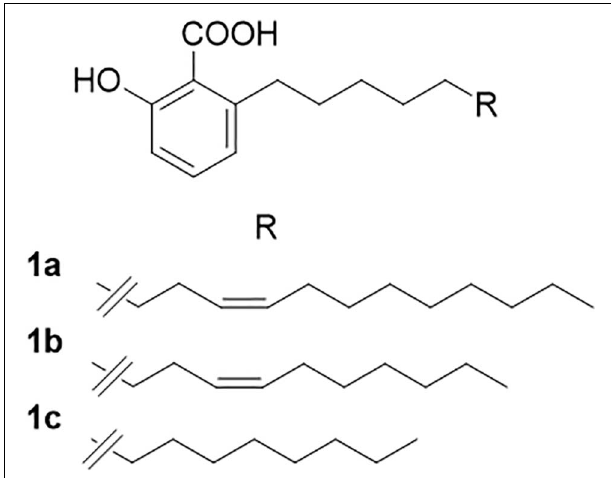
FIGURE 1 | Anacardic acids from lentisk ( Pistacia lentiscus L.) oil. (A) C17:1; anacardic acid; 49% of the mixture. (B) C15:1; ginkgolic acid-1; 36% of the mixture. (C) C13:0; anacardic acid; 9% of the mixture.